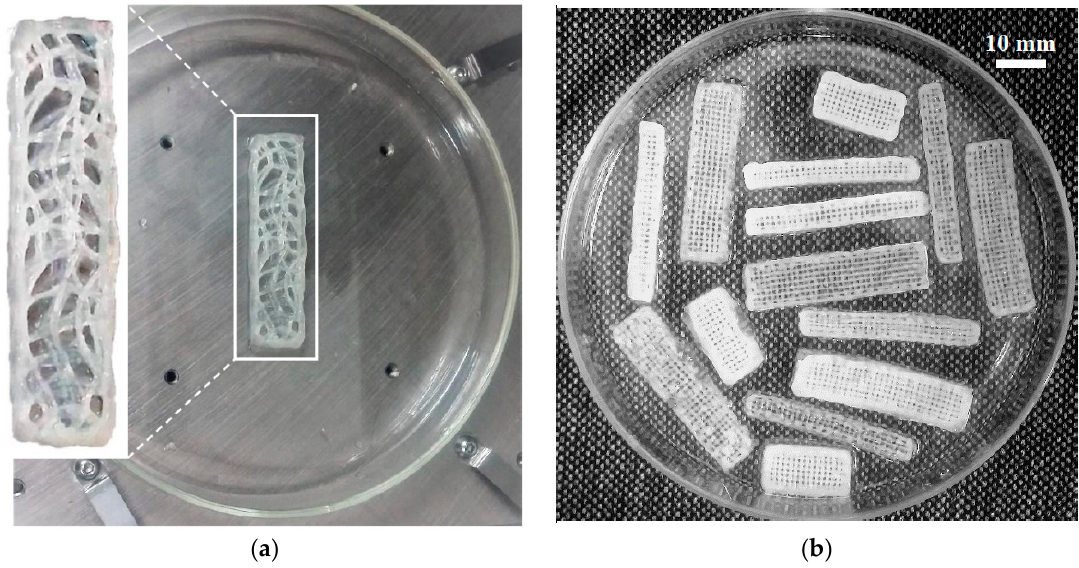
Figure 1. ( a ) An arbitrary pattern 3D printed polyelectrolyte actuator and ( b ) different patterns and sizes of 3D-printed polyelectrolyte